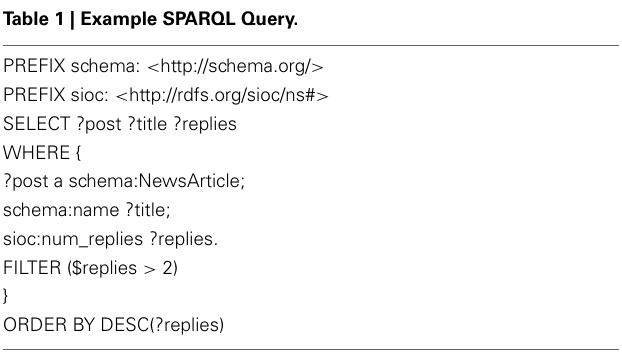
Table 1 | Example SPARQL